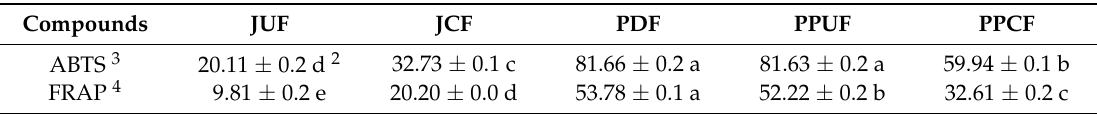
Table 4. Antioxidant capacities of juice and dry pomace prepared from uncrushed and crushed black chokeberry fruits (mmol Trolox/100 g dm) 1 .